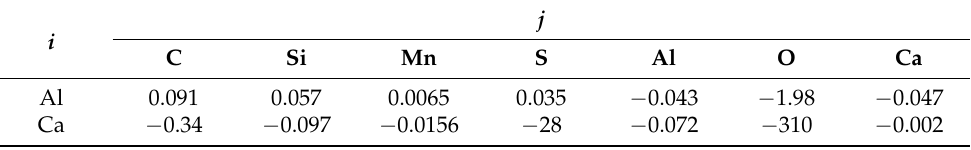
Table 4. The interaction coefficients between elements.